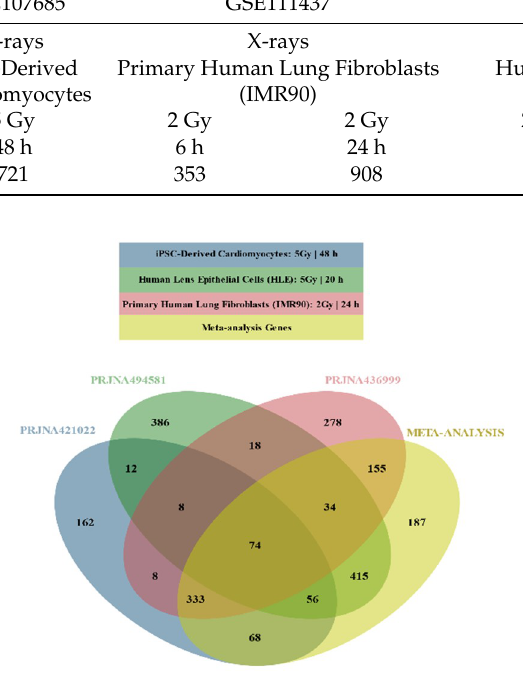
Figure 1. Venn diagram illustrating overlapping Differentially Expressed Genes (DEGs) across selected DEG lists and meta-analysis results.